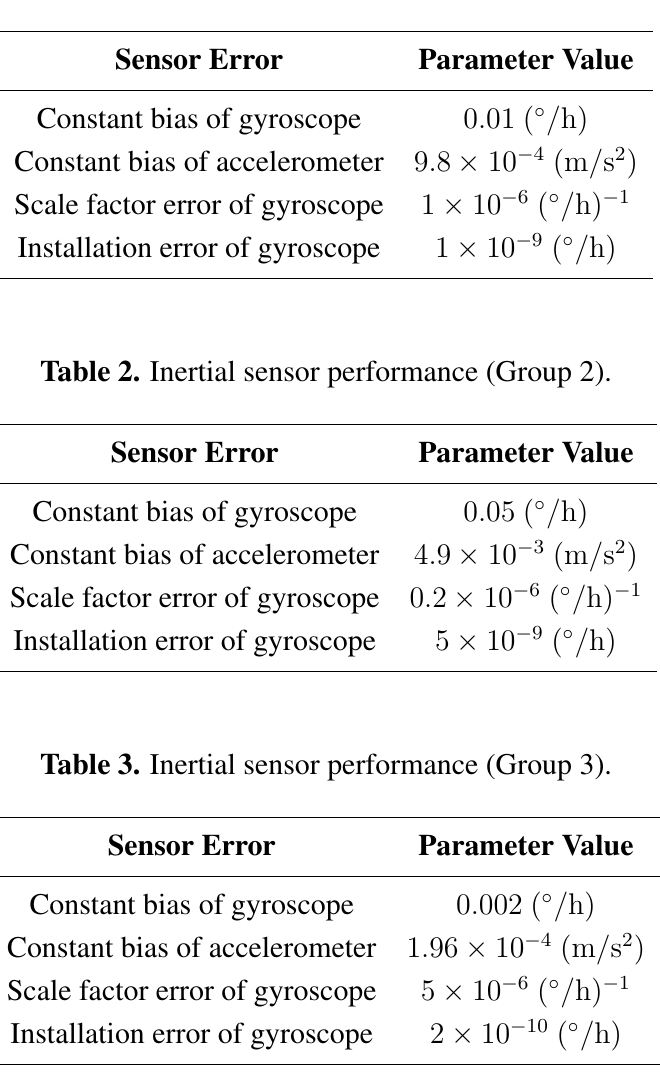
Table 1. Inertial sensor performance (Group 1).